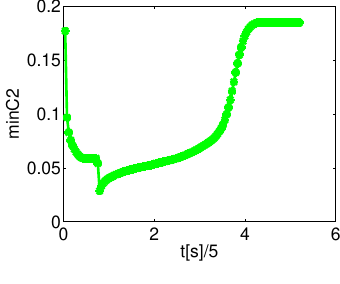
Figure 11. Minimum concentration of O 2 vs. t at t f =0.4.